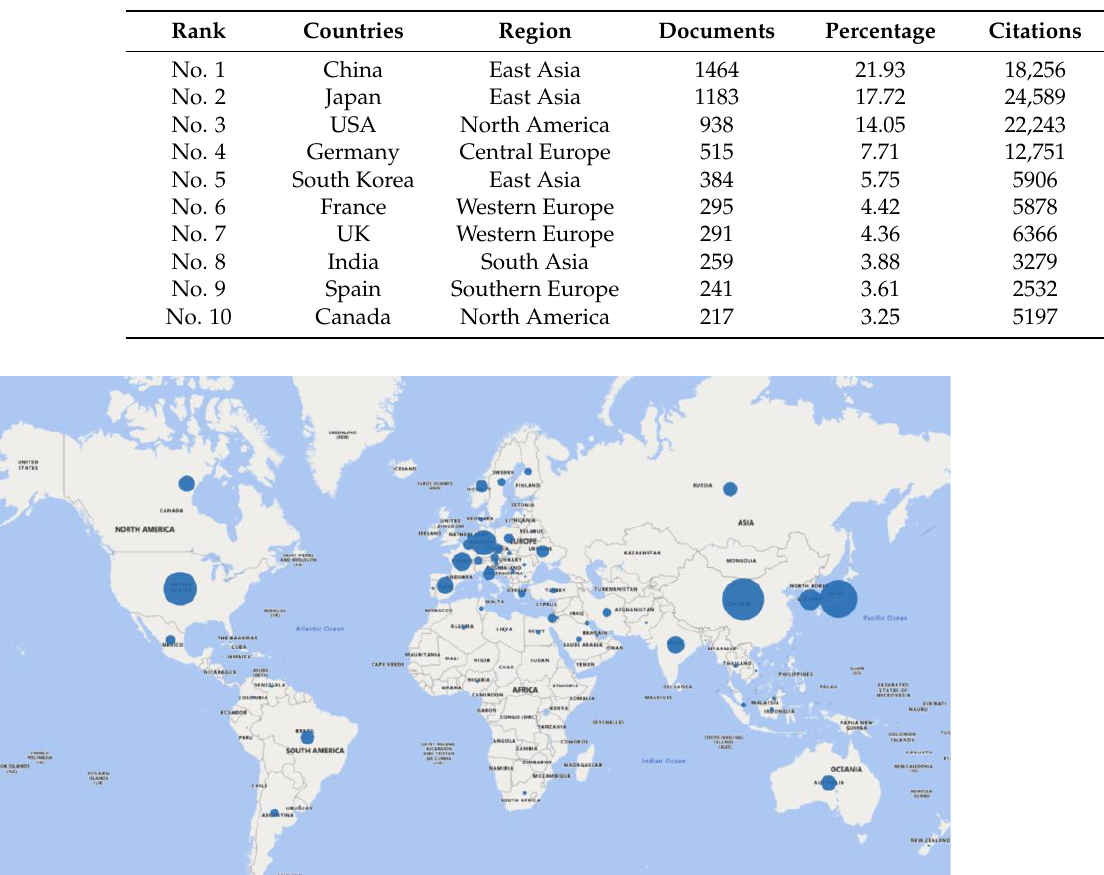
Table 2. Top ten countries for the number of publications related to hydrogen embrittlement from 1997~2022.